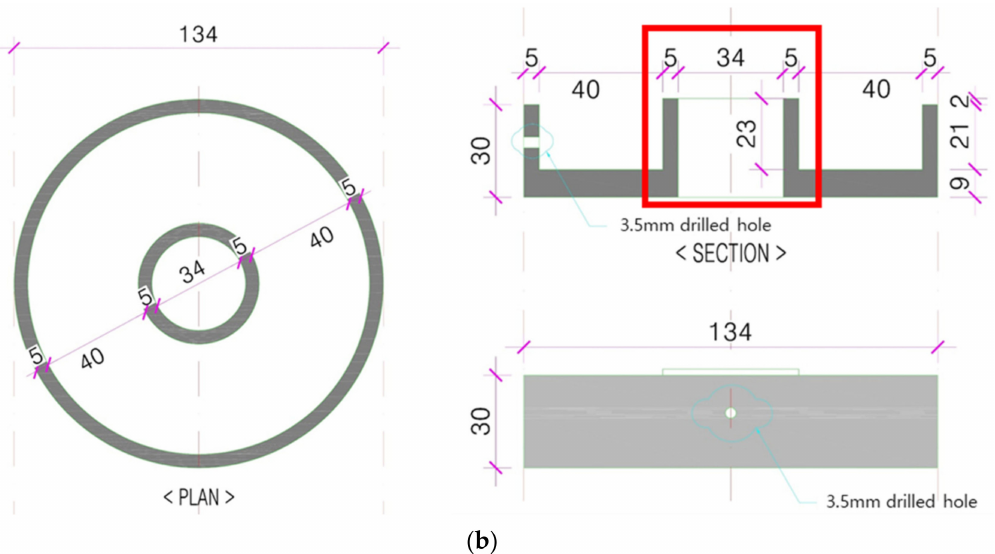
Figure 6. Scaffolding to which the prototype applies and drawings of the prototype. ( a ) Design of elastic strain member and Jack base: (bottom of system support/Jack base); ( b ) design of the elastic strain member.